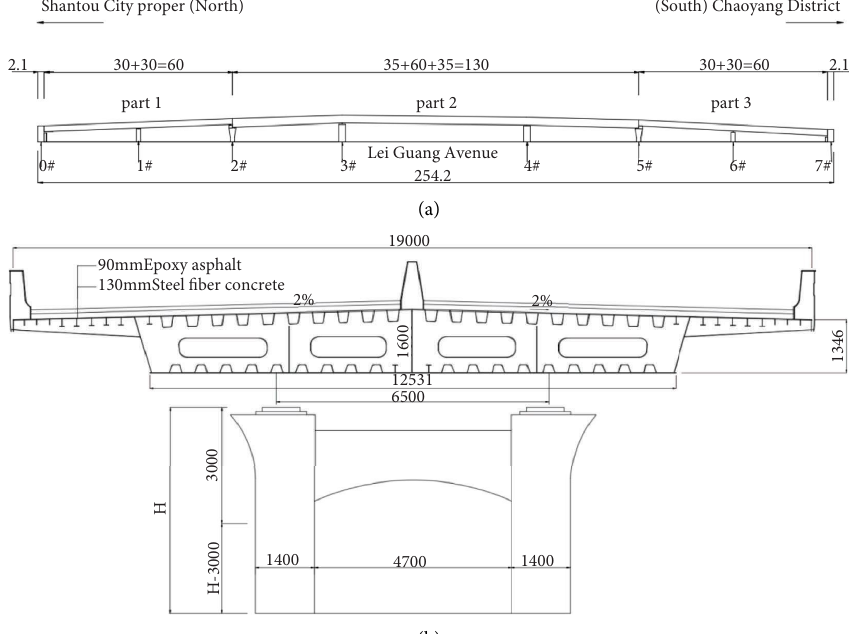
Figure 1: Layout of Leiguang Bridge and cross section of steel box girder. (a) Bridge elevation (unit: m). (b) Cross section of steel box girder and double-column pier (unit: mm).